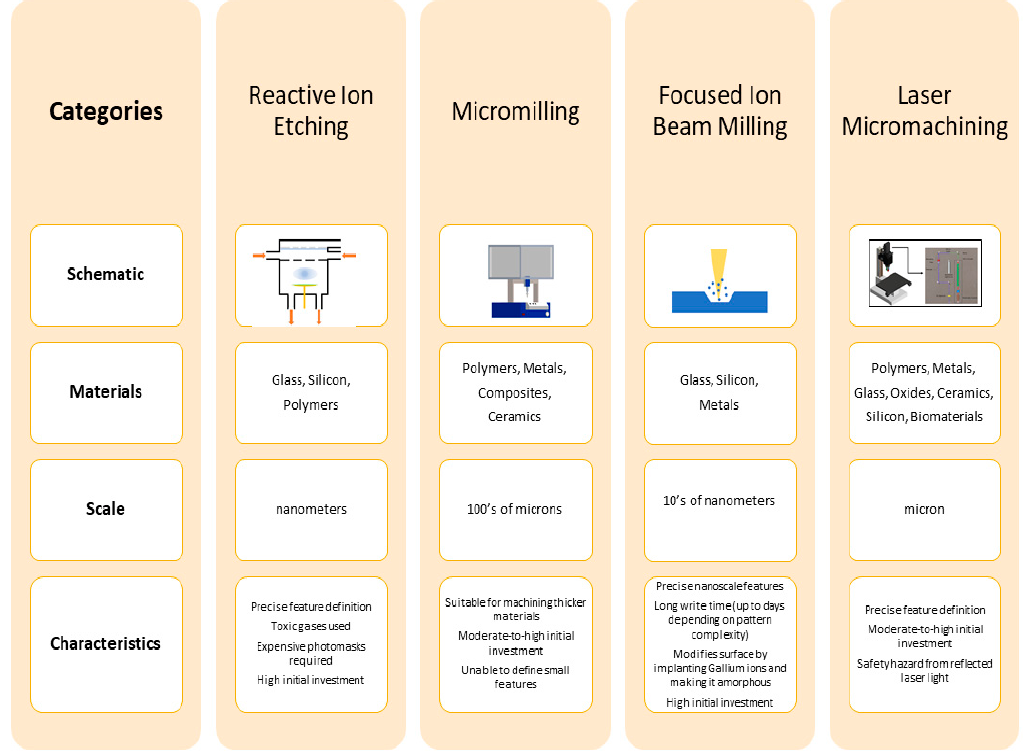
Figure 1. Comparison of three widely used direct-write fabrication methods (reactive ion etching (RIE) [15,17], micromilling [14], and focused ion beam (FIB) [13,16,18]) to laser micromachining. Each of these methods allows for high aspect ratio, serial, single-substrate fabrication. In the case of RIE multi-wafer / multi-substrate parallel processing is also possible as with some laser micromachining examples as well for higher throughput micro /